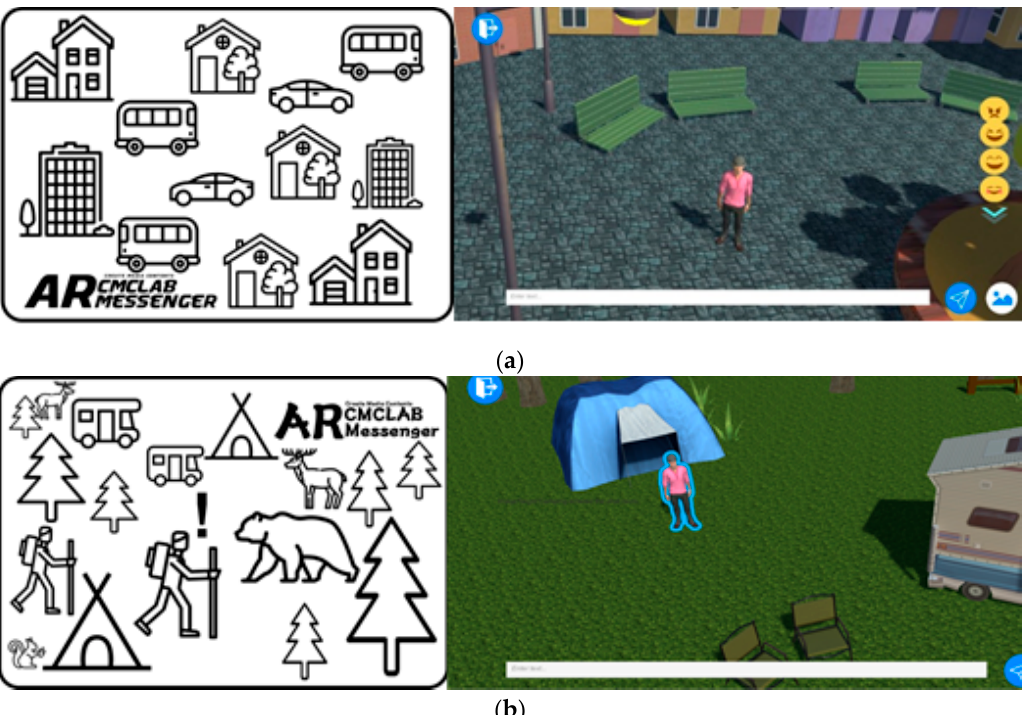
Figure 7. Maps with markers provided by our application. ( a ) City map and marker. ( b ) Camping map and marker.